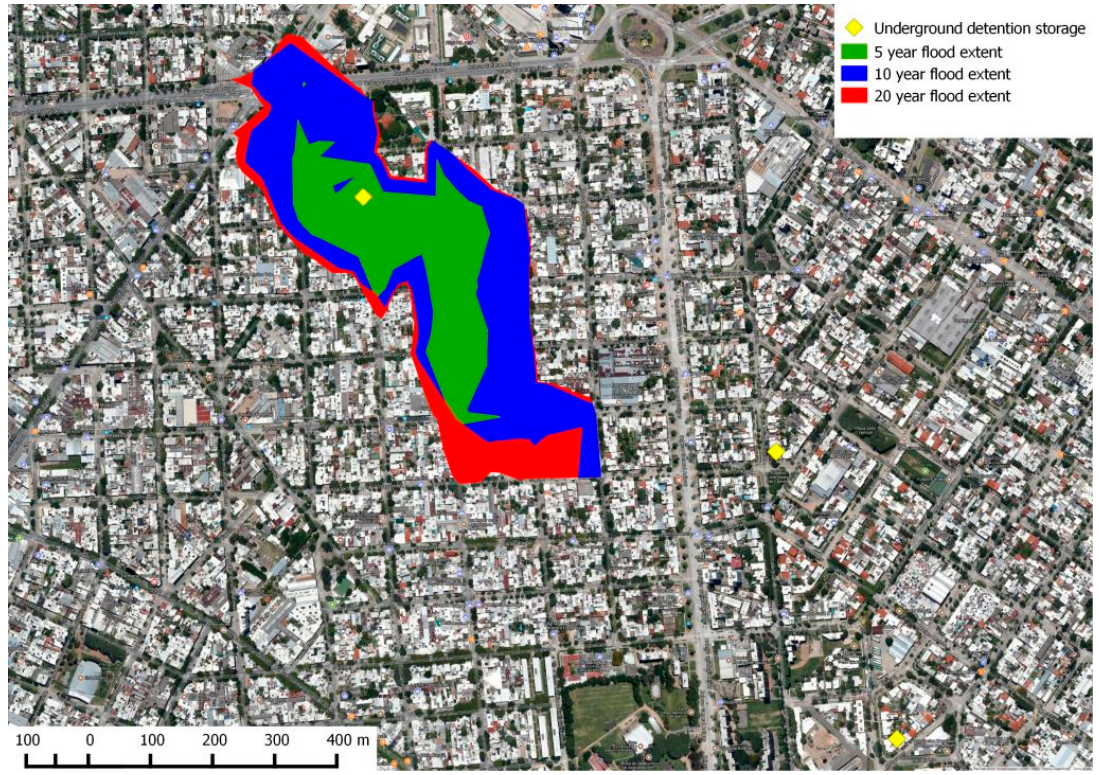
Figure 5. Location of proposed underground detention storage tanks and flooded extents for 5-, 10- and 20-year storm events in Quitacalzones catchment.